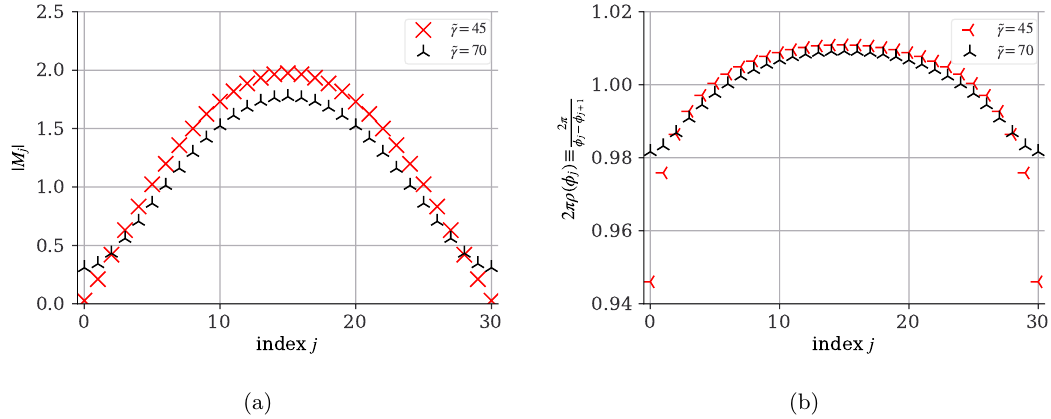
Figure 5. (a) θ = 0 numerical results for the | M j | versus j for N = 30 in the partial phase, for ˜ γ = 45 (red crosses) and 70 (black 3-point stars). Notice that | M 0 | is small but non-zero. (b) Using eq. (2.23), with g 2 = 0 . 1 , we converted the results of (a) into the Polyakov loop eigenvalue distri- bution 2 πρ ( φ j ) = 2 π versus j . The eigenvalue distribution is not flat, indicating spontaneous φ j − φ j +1 breaking of centre symmetry, and is not gapped, indicating that the phase is not deconfined. We thus identify these as partial phase solutions.